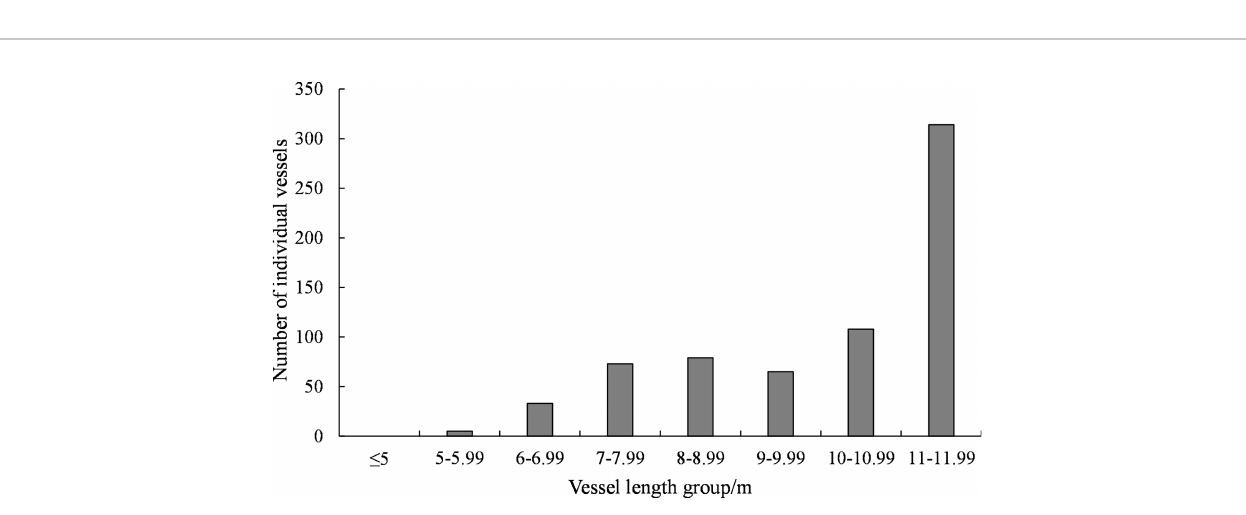
FIGURE 3 | Number of vessels per length category (in meters) for small-scale fi sheries in Shengsi